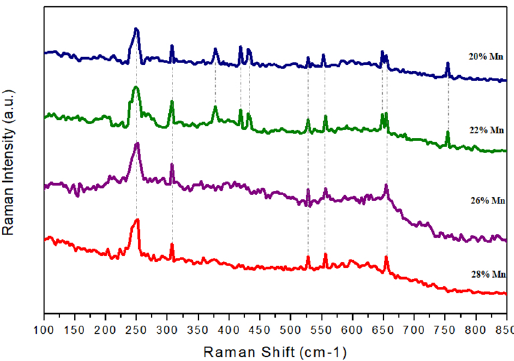
Figure 16. Raman spectrum of corrosion products of high manganese steels after the linear polarization test in solution 0.1M of